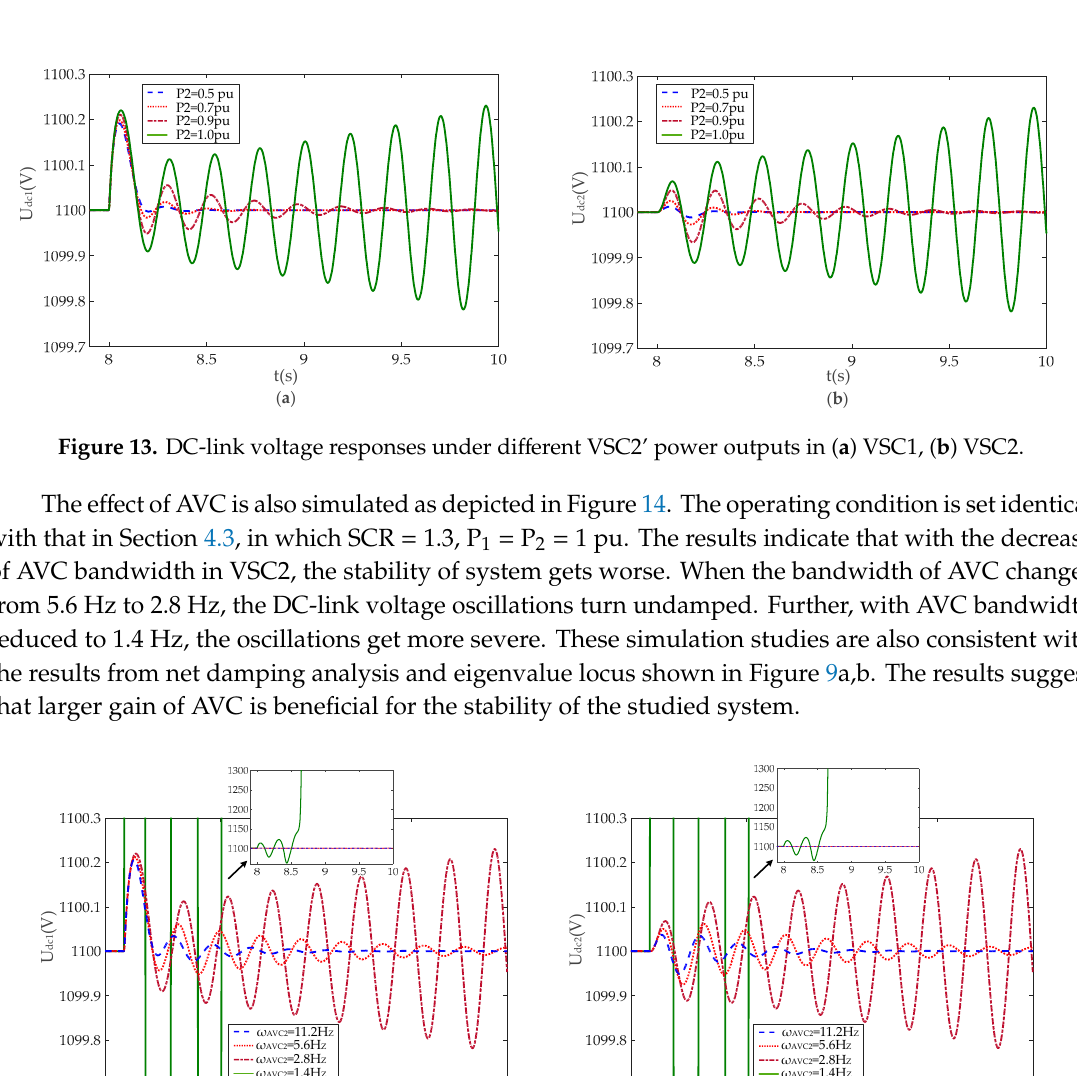
Figure 13. DC ‐ link voltage responses under different VSC2’ power outputs in ( a ) VSC1, ( b ) VSC2.